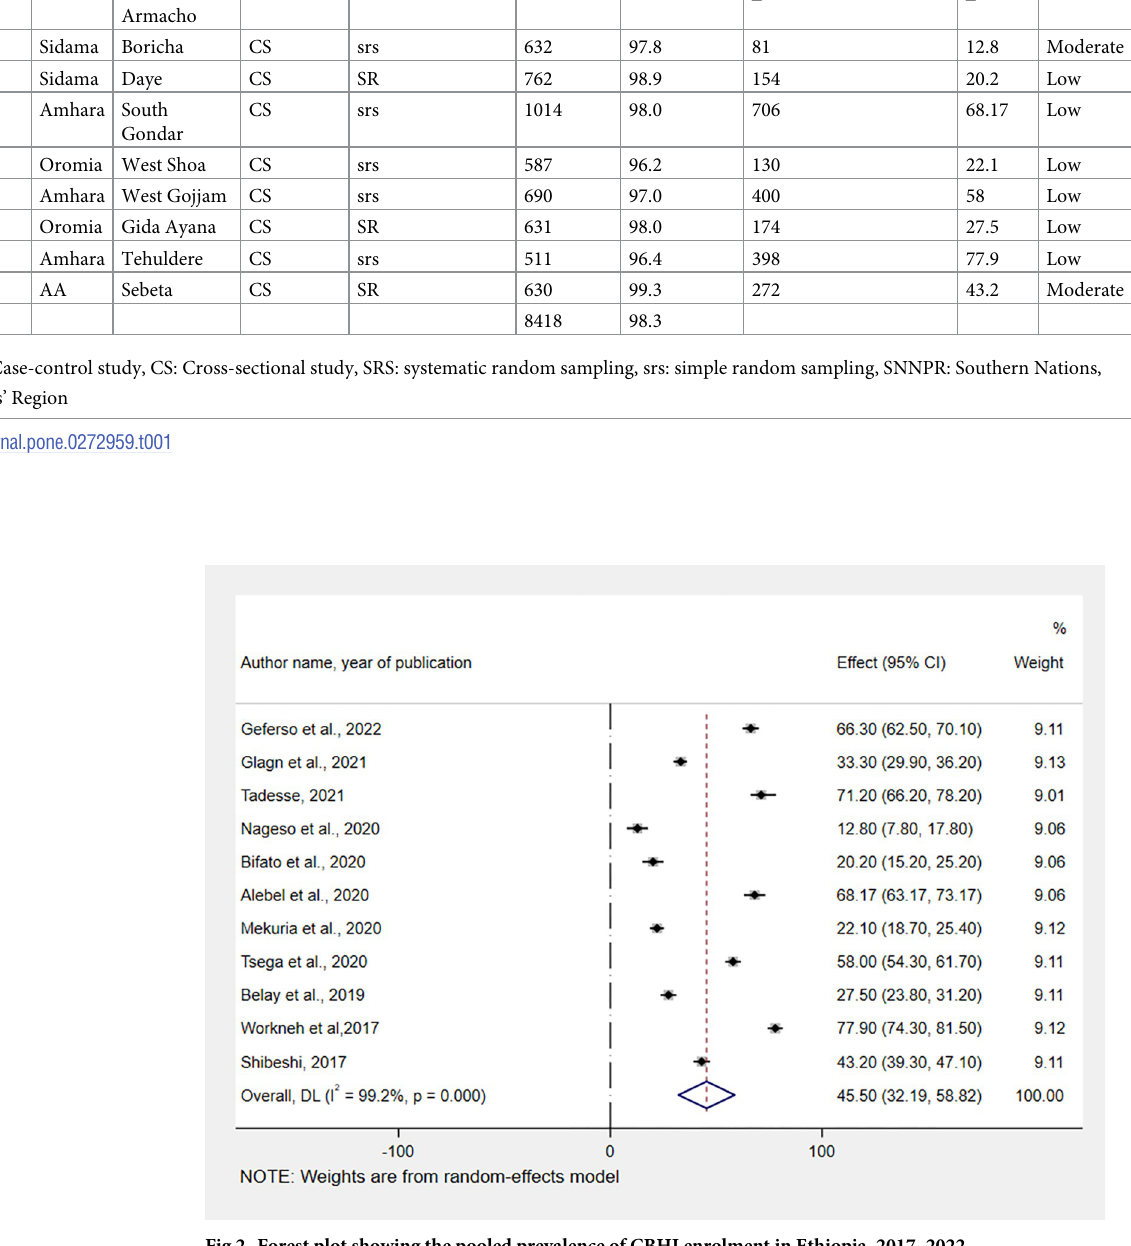
Fig 2. Forest plot showing the pooled prevalence of CBHI enrolment in Ethiopia, 2017–2022.